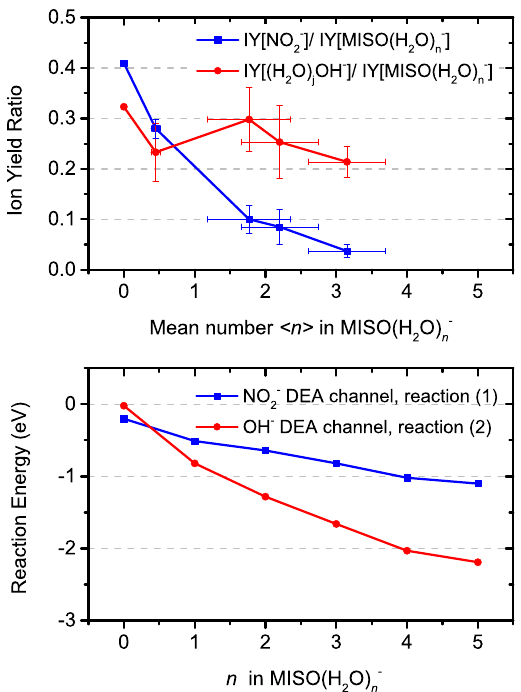
Figure 4. Evolution of relative ion yields for OH − and NO − computed reaction energies for respective DEA reaction channels ( bottom